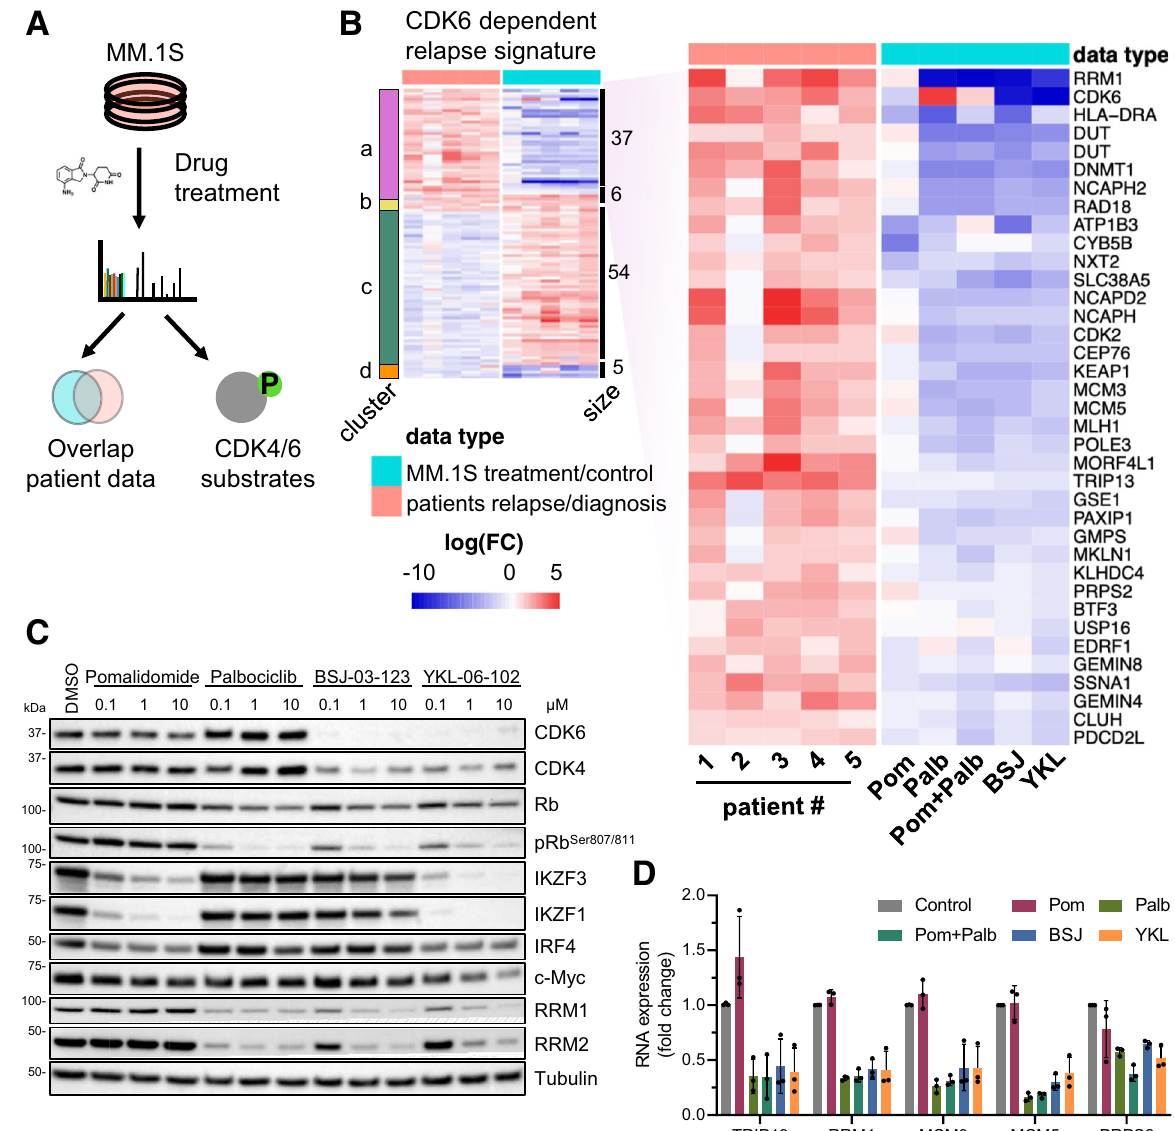
Fig. 6 Targeting CDK6 in myeloma cells reverses a relapse protein signature. A Proteomic and phosphoproteomic changes of MM1.S cells treated with different drugs and combinations were assessed with TMT-based proteomics. B Combined heatmap displaying protein levels of paired-patient data and cell perturbation data. MM.1S cells were treated for 24 h with pomalidomide (pom), palbociclib (palb), in combination (pom + palb), BSJ-03-123 (BSJ), and YKL-06-102 (YKL). C Western blot analysis of MM.1S cells treated for 16 h with respective treatments at indicated concentrations ( N = 3